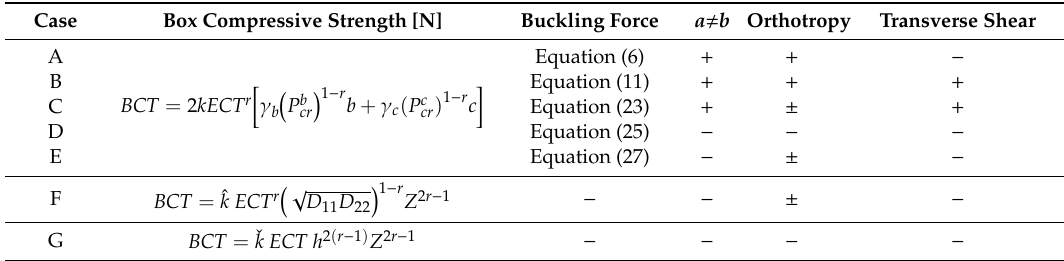
Table 1. Analytical approaches for the determination of the box compressive strength.